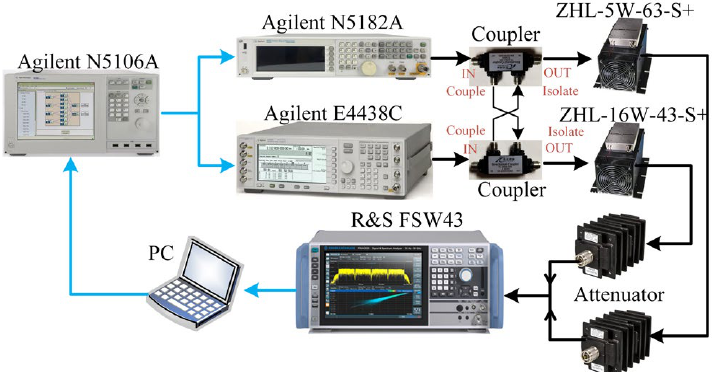
Figure 5. The block diagram of the platform setup when nonlinear crosstalk is introduced.